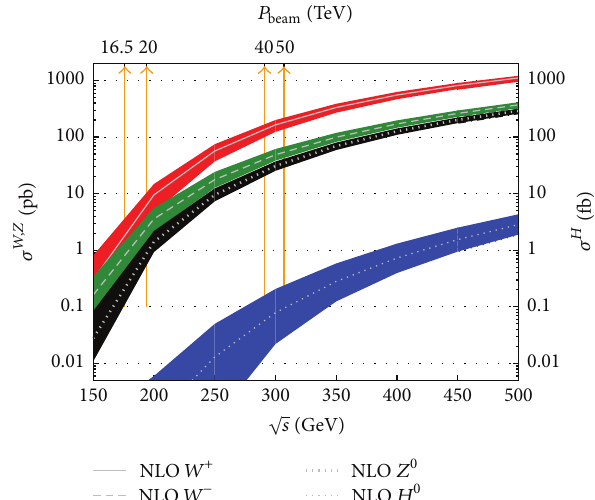
Figure 2: Cross sections for Standard Model boson production in proton-proton collisions at various centre-of-mass (lower 𝑥 -axis) andcorrespondingbeamenergiesinthefixed-targetmode(upper 𝑥 - axis). The color bands indicate the 1- 𝜎 values coming from the PDF uncertainty. The NLO calculations were performed with CT10NLO [27]byusingmcfm[28]with 𝜇 𝐹 = 𝜇 𝐹 settothemassoftheproduced particle.The4orangearrowspointatthebeamenergyofthe4setups which we have